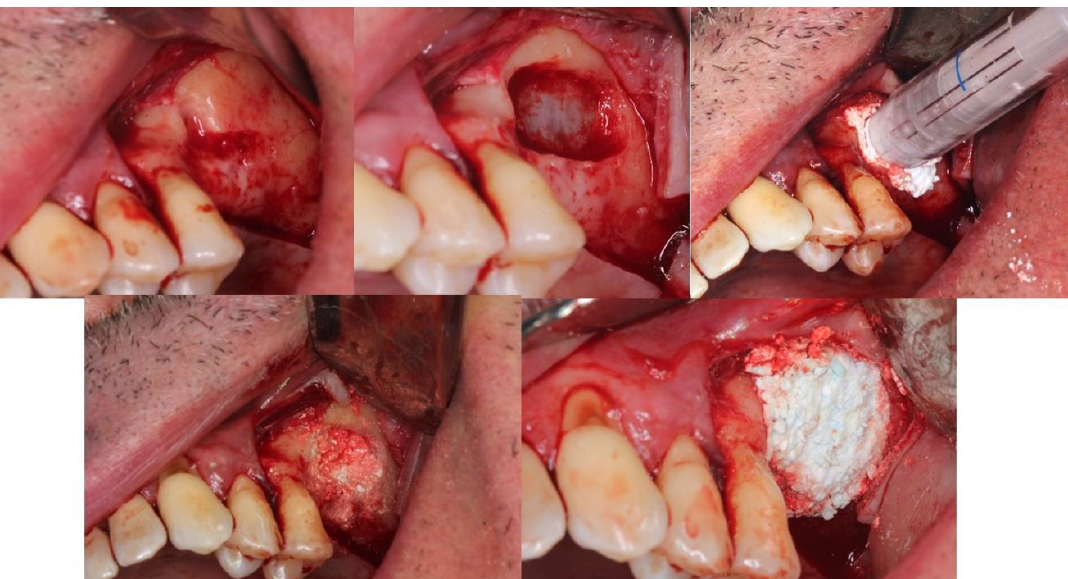
Figure 18. ( A ) Preoperative CBCT; ( B ) Immediate postoperative CBCT; ( C ) Postoperative CBCT after 4 months.